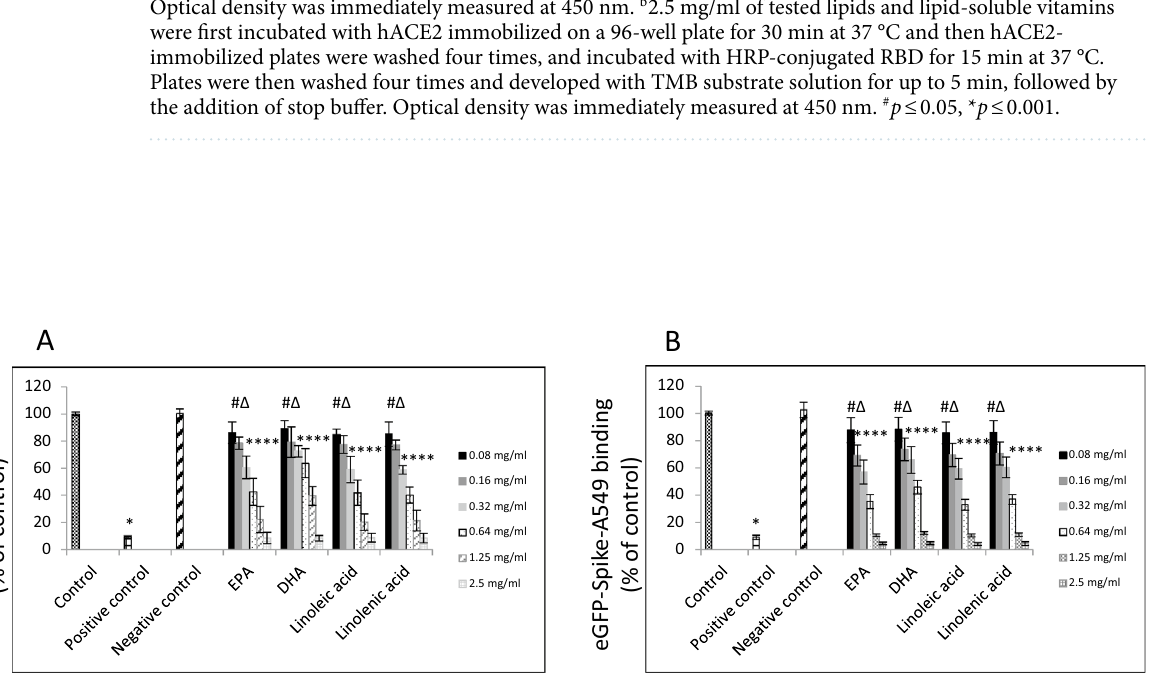
Figure 1. Effects of PUFAs on binding of RBD sequence of SARS-CoV-2 to human ACE2 receptor. ( A ) Binding of RBD sequence of SARS-CoV-2 spike protein to immobilized hACE2 receptor. HRP-conjugated RBD sequence was treated with indicated FAs at different concentrations for 30 min. followed by incubation for 15 min. with hACE2 receptors immobilized on plate. HRP signal was measured at 450 nm. ( B) Binding of A549 cells expressing SARS-CoV-2 eGFP-spike protein in the present of selected FAs at different concentrations to soluble hACE2 receptor. Binding was performed on plates with immobilized human monoclonal antibody against hACE2 receptor at 10 µg/ml concentration and detected as green fluorescence signal. Data are presented as % of control ± SD; # p ≤ 0.05, ∆ p ≤ 0.01, * p ≤ 0.001. Control—0.025% DMSO, positive and negative controls were provided by the